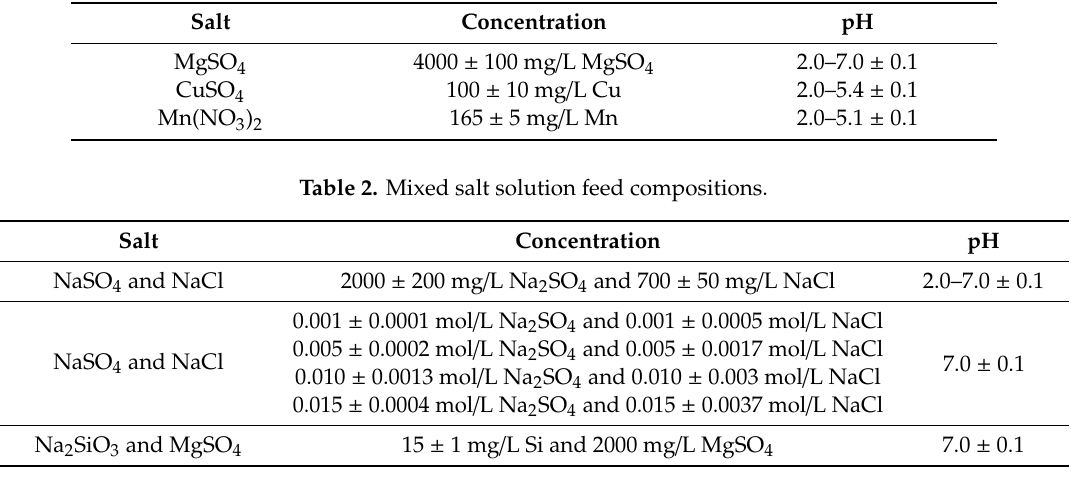
Table 1. Single salt solution feed compositions.